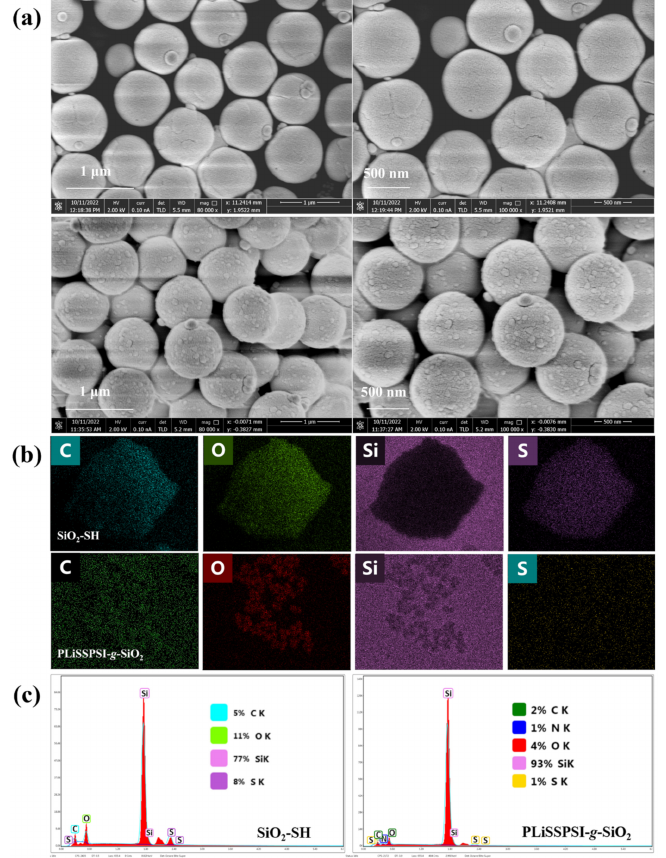
Figure 4. ( a ) SEM images, ( b ) elemental mapping and ( c ) EDS analysis of SiO 2 -SH and PLiSSPSI- g -SiO 2